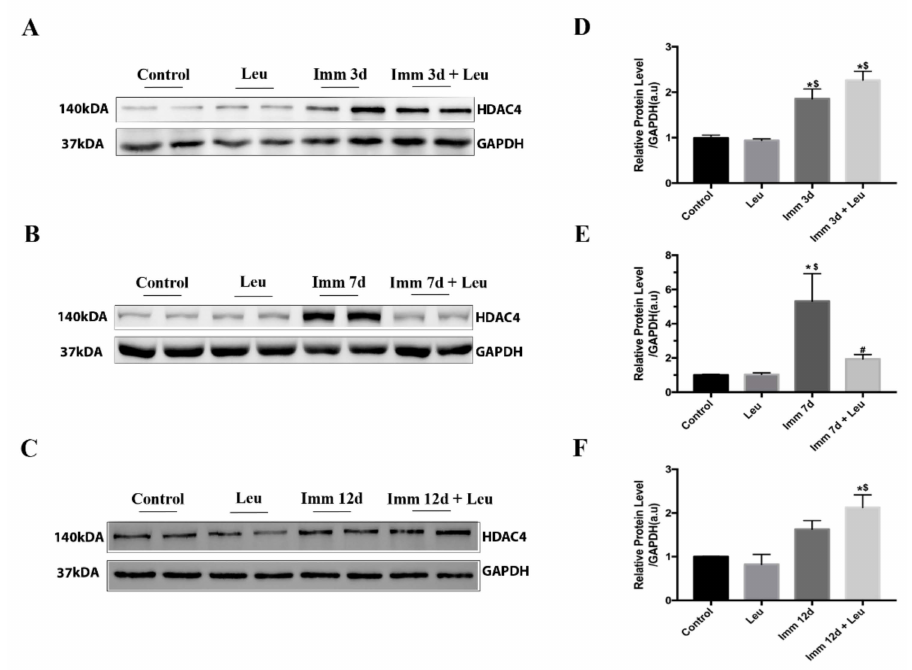
Figure 3. E ff ect of leucine on HDAC4 protein expression. Protein levels of HDAC4 were determined at 3 days, 7 days and 12 days of immobilization in leucine supplemented, immobilized, and immobilized leucine supplemented groups. ( A ) HDAC4 Western blot showing representative bands at 3 days, ( B ) 7 days, and ( C ) 12 days. Note that Control and Leucine groups were submitted to di ff erent conditions; 3, 7 and 12 days of saline and leucine supplementation respectively. ( D ) Densitometry analysis at 3 days ( n = 6 per group), ( E ) 7 days ( n = 9 per group), and ( F ) 12 days ( n = 4 per